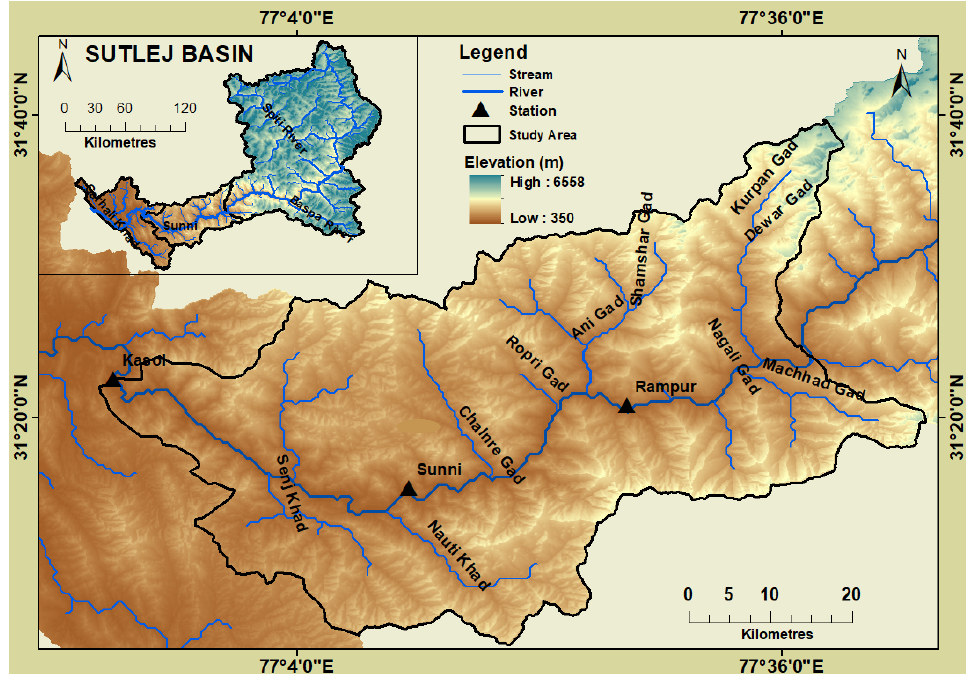
Figure 1. The location of the sub-catchment within Sutlej River basin. The three hydrometeorological stations (Kasol, Sunni, and Rampur), from which this study employed observed data for the years 1979 to 2009, are also shown.